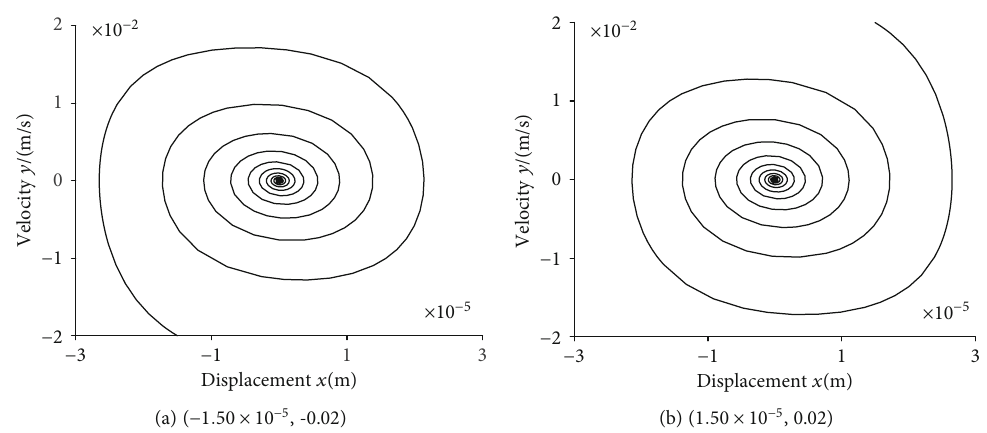
= 5 : 0 × 10 − 5 m , l = 5 : 0 × 10 − 5 m . 0